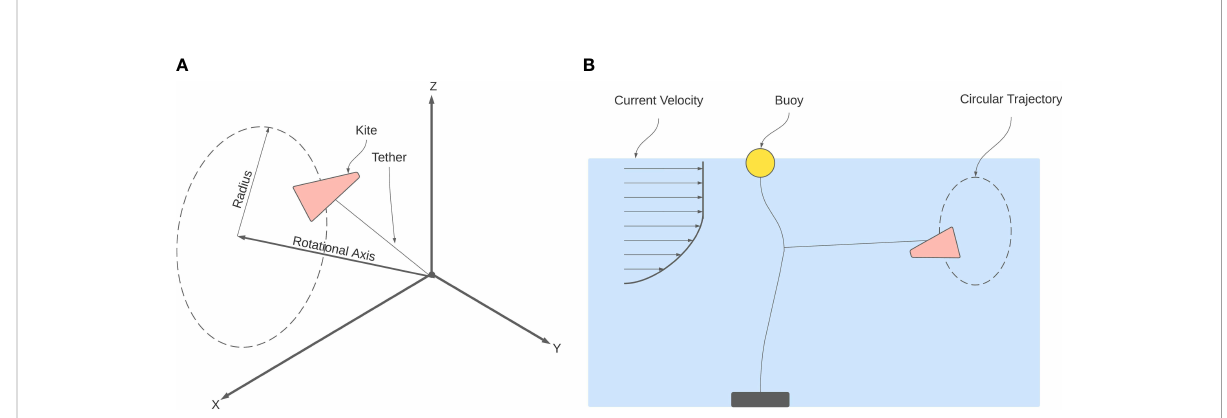
FIGURE 1 (A) Schematic drawing of the TUSK in crosscurrent motion, it is moving in a circular path indicated here by the dotted line. (B) The TUSK is shown as it would be deployed in the fi eld, anchored in between the ground and the buoy using the